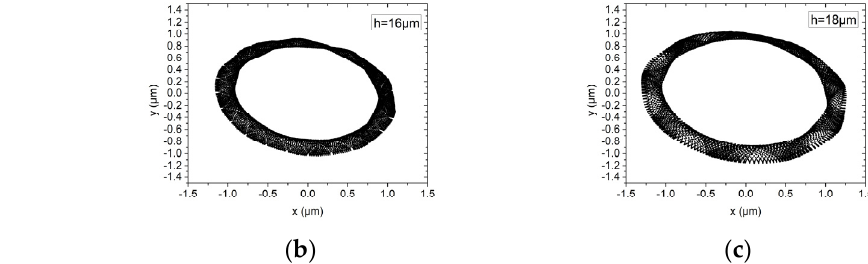
Figure 11. Rotor center trajectory under different gas film thickness under working condition 5 (high speed, dynamic unbalance G1), ( a ) rotor center trajectory (h = 14 μ m), ( b ) rotor center trajectory (h = 16 μ m), ( c ) rotor center trajectory (h = 18 μ m).